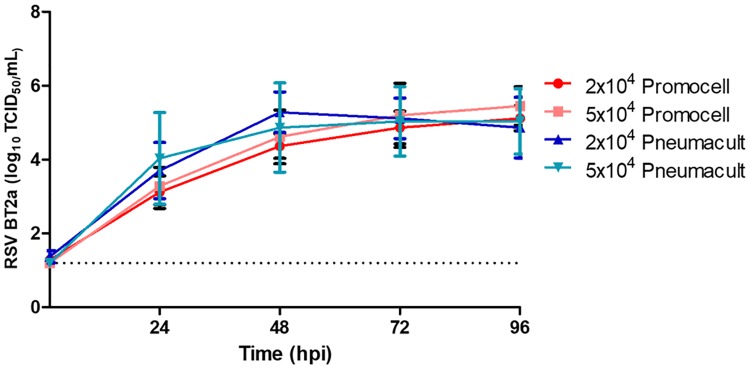
Primary paediatric nasal epithelial cells (n = 3 donors) seeded on collagen coated Transwell supports at a seeding density of 2x104 or 5x104 per Transwell.Were maintained in either Promocell or Pneumacult medium for 21 days. Cultures were infected with RSV BT2a 1.4x105 TCID50. Apical washes were harvested at 2 and 24 hpi and every 24 h thereafter and titrated on HEp-2 cells to determine virus growth kinetics. RSV-infected cultures were fixed at 96 hpi and the total number of cells and the number of ciliated, goblet and RSV-infected cells were enumerated in en face IF images (Fig 5). Following infection, the mean number of cells was significantly different between Promocell- and PneumaCult-differentiated cultures, with a 46% and 37% reduction in mean cell numbers, respectively. All cultures demonstrated a similar loss in ciliated cell numbers following RSV infection, 20% and 23% reduction for Promocell and PneumaCult, respectively. There were significantly more RSV-infected cells in the PneumaCult cultures, consistent with higher numbers of ciliated cells in these cultures compared to the Promocell cultures. However, despite the higher numbers of ciliated cells, as previously mentioned (Fig 3B), and the greater number of RSV-infected cells (Fig 5B), the viral growth kinetics were not significantly different. The percentage of ciliated, goblet and RSV-infected cells in the cultures did not differ significantly as a function of the culture medium used.